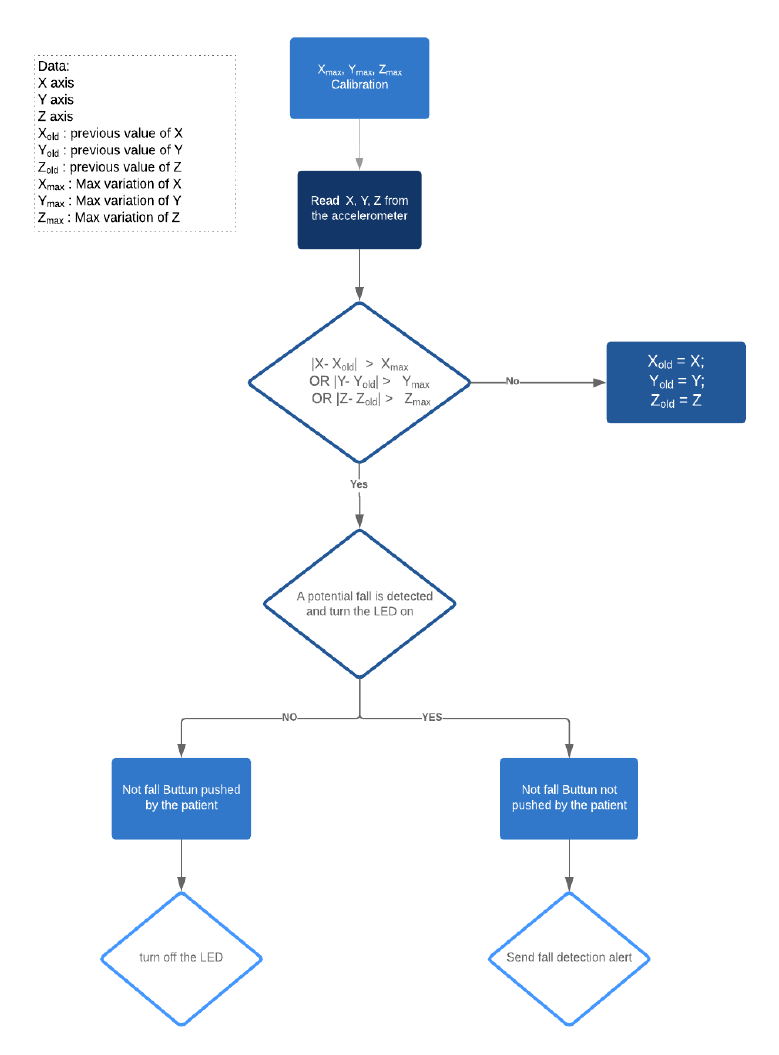
Figure 5. Simple fall detection algorithm using an